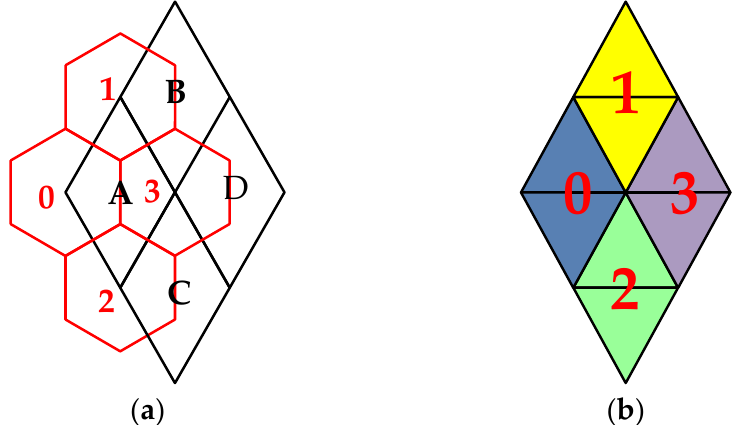
Figure 10. Corresponding relationship of different cells. ( a ) Corresponding relationship between hexagon grid and diamond grid; ( b ) Corresponding relationship between triangle grid and dia- mond grid.